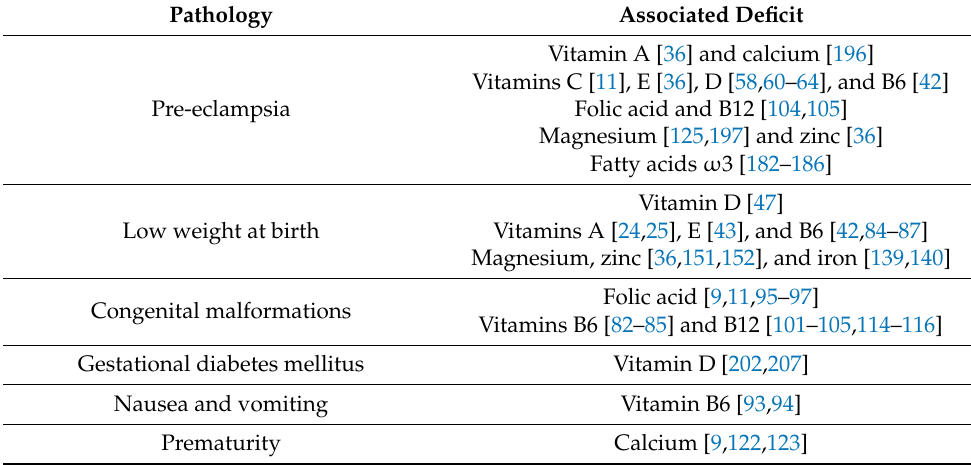
Table 3. Pathologies associated with nutritional deficits during